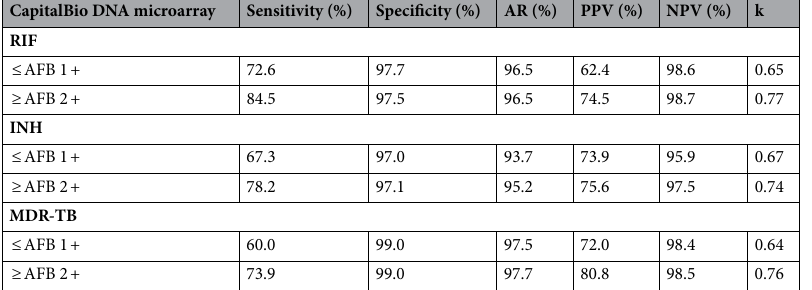
Table 4. Comparison of the diagnostic efficacy of the DNA microarray method when sputum smear grades were ≤ 1 + and ≥ 2 + DST drug sensitivity test, R resistant, S susceptible, AR agreement rate, PPV positive predictive value, NPV negative predictive value, AFB acid-fast